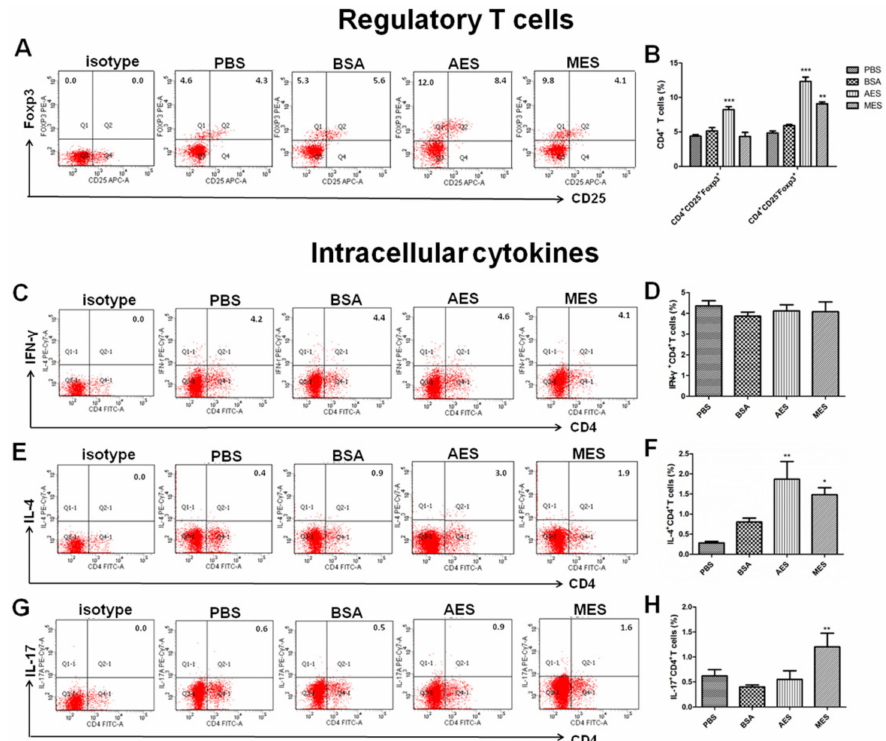
Figure 8. Ts ES-pulsed DCs induced Treg cell di ff erentiation and Th2 cytokine in naive CD4 + T cells in vivo. The splenocytes were isolated from naive BABL / c mice passively transferred with Ts AES-, Ts MES-, PBS-, and BSA-treated BMDCs. ( A ) The frequencies of CD4 + CD25 + Foxp3 + and CD4 + CD25 - Foxp3 + T cells were measured by gated flow cytometry. ( B ) The percentages of CD4 + CD25 + Foxp3 + T cells and CD4 + CD25 - Foxp3 + T cells are presented as the mean ± SEM of five individual mice per group. ( C , D ) Frequencies of CD4 + T cells producing IFN- γ + , ( E , F ) frequencies of CD4 + T cells producing IL-4 + , and ( G , H ) frequencies of CD4 + T cells producing IL-17A + are shown. The data are presented as the mean ± SEM of three independent experiments. * p < 0.05; ** p < 0.01; *** p < 0.001 in a one-way analysis of variance followed by Bonferroni